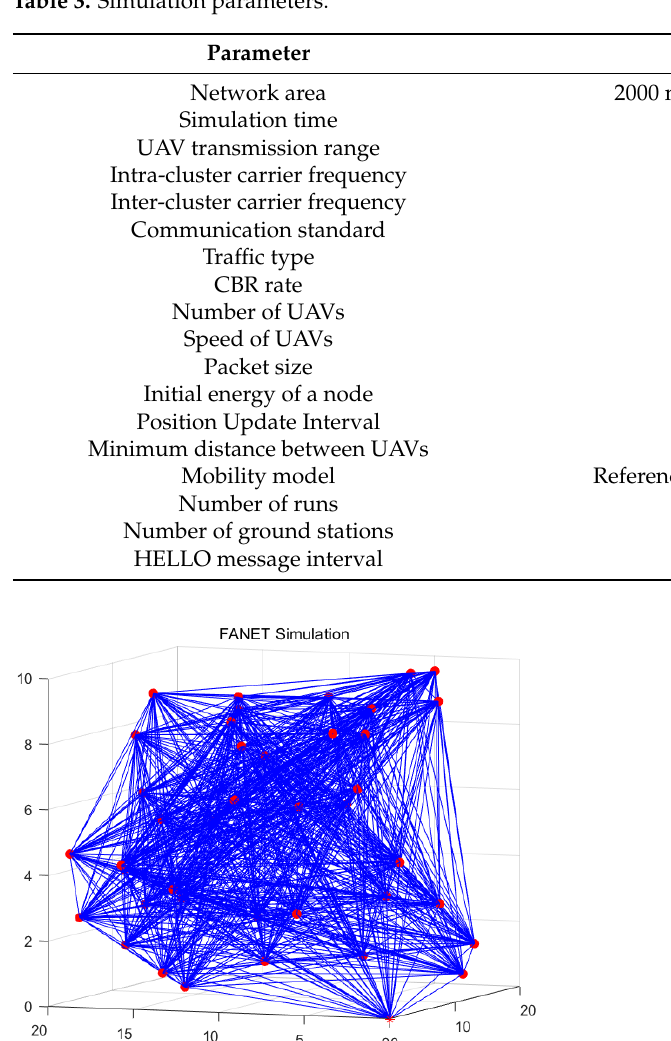
Table 3. Simulation parameters.